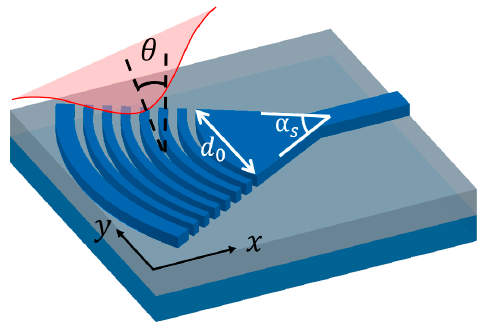
Figure 4. Schematic diagram of a focusing GC with curved grating lines.